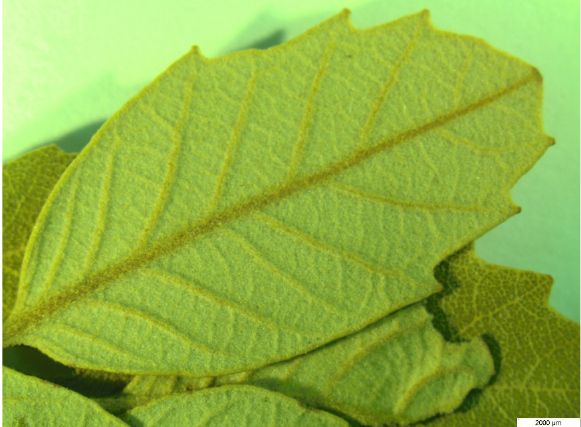
Figure 6. Leaf detail of Q. × alvesii Vila-Viçosa, Capelo, R. Almeida & F.M. Vázquez nothosp.nov. PO-V62235! (Porto University, Natural History and Science